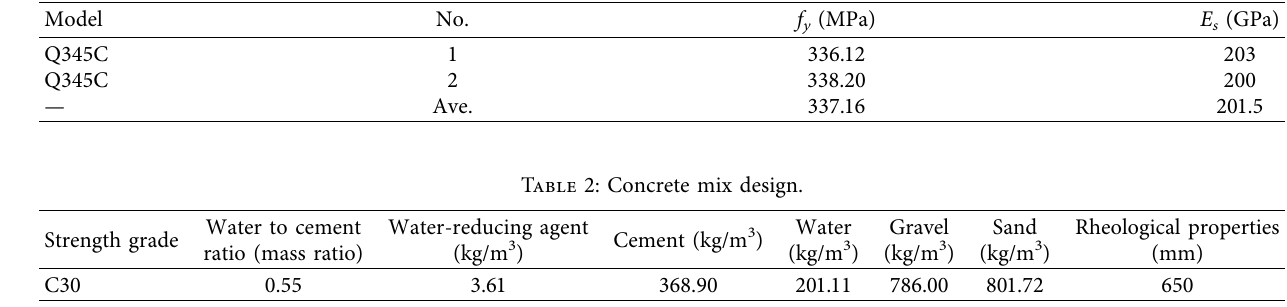
Table 1: Mechanical properties of steel.